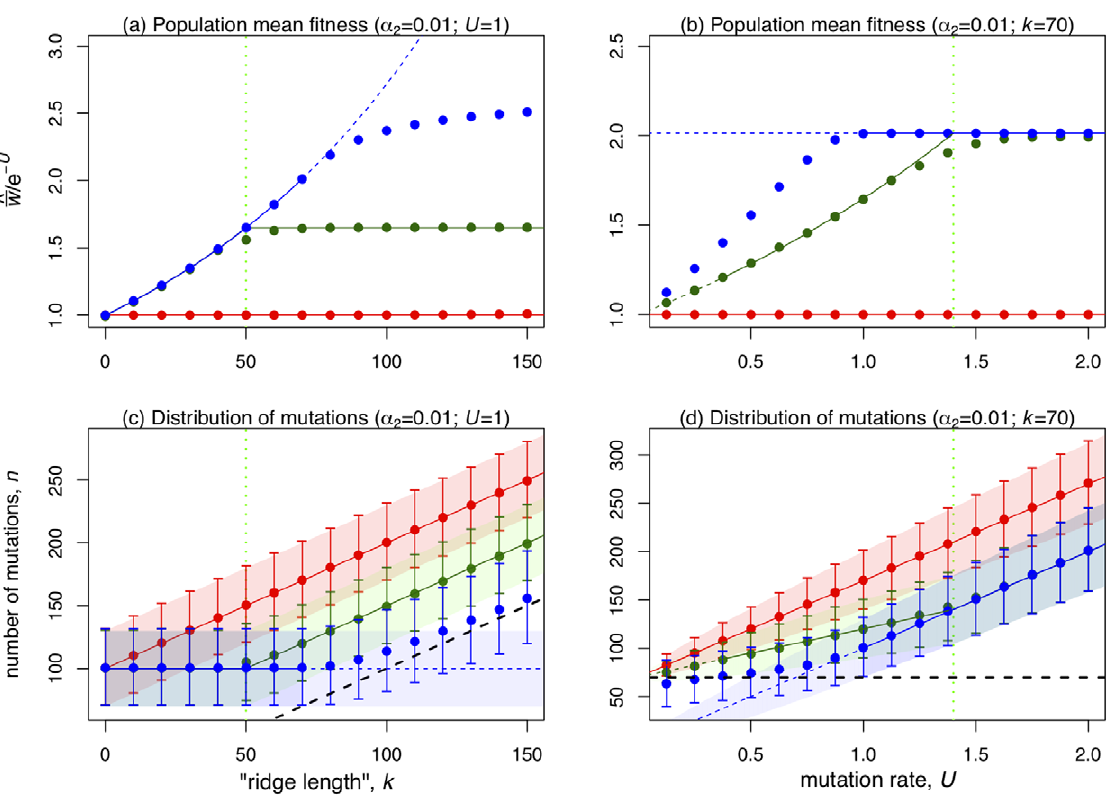
Figure 3. Results for populations at mutation-selection equilibrium in the special case a 1 ~ b ~ 0 . Results for the three modes of reproduction are coloured Red: asexual reproduction; Blue: sexual reproduction with free recombination; and Green: sexual reproduction with segregation alone. The x-axes vary the ‘‘ridge length’’, k (Panels (a) and (c)), or the genomic deleterious mutation rate, U (Panels (b) and (d)). Panels (a) and (b) show the equilibrium mean fitness of the populations, ^(cid:2) ww (cid:2) ww . Points show exact numerical results, and solid lines show analytical approximations from Table 1. These solid lines become dashed in regions of parameter space in which hidden epistasis is not predicted (Table 1), and so where the normal approximations might not apply. Panels (c) and (d) represent the genetic constitution of the populations, with points showing the mean number of mutations carried, m , and error bars delimiting 99.75% of the population (corresponding to 3 standard deviations of the normal distribution). Coloured areas show the analytical approximations for m + 3 s (Table 1). The thick dashed black line shows n ~ k , and so populations who do not overlap with this line are said to exhibit hidden epistasis. Dashed coloured lines, and lighter shading denote the parameter regimes where hidden epistasis is not predicted (Table 1). The vertical light-green dotted lines shows the transition between the two possible parameter regimes for sex with segregation alone ( U ~ 2 k a 2 ).